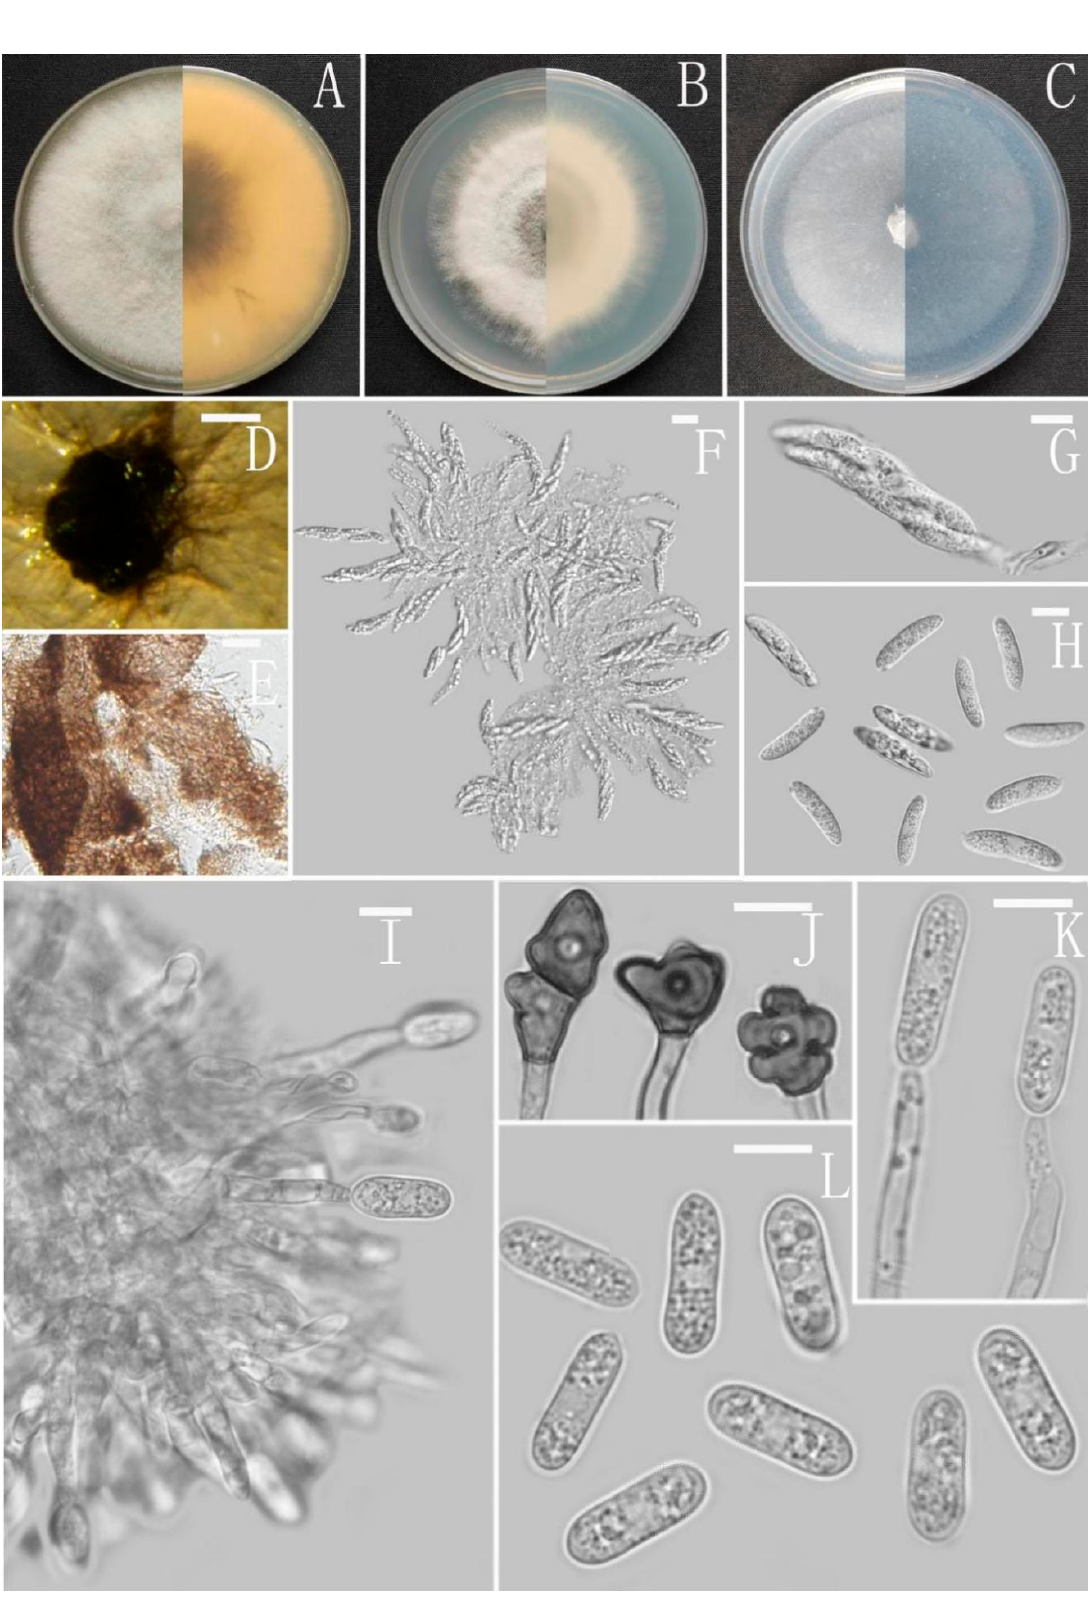
Figure 6. Colletotrichum gracile (YMF1.06939). ( A – C ) Colonies on media above and below after 7 days at 25 °C (( A ) MEA; ( B ) PDA; ( C ) SNA). ( D ) Ascomata. ( E ) Outer surface of peridium. ( F – G ) Asci. ( H ) Ascospores. ( I ) Conidiophores and Conidia. ( J ) Appressoria. ( K ) Conidiophores. ( L ) Conidia. Scale bars: ( D ) = 100 μ m, ( E – K ) = 10 μ m.